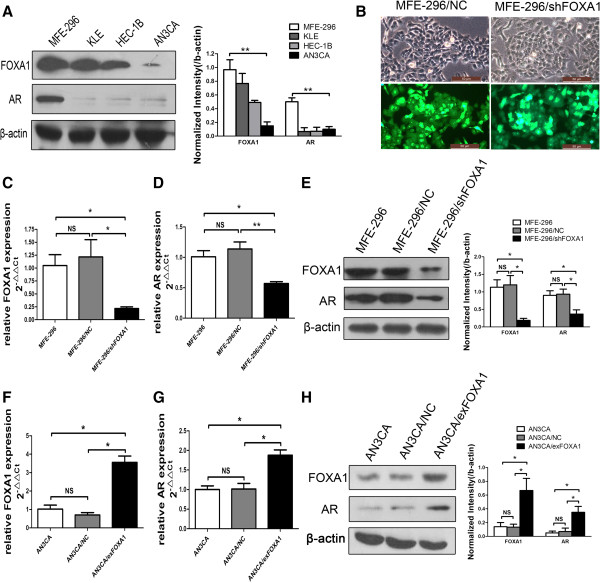
FOXA1 affects the expression of AR in human EC cells. A: FOXA1 and AR expression in the indicated EC cell lines as determined were measured by western blotting (Left), and further quantified by densitometry of triplicate experiments (Right). β-actin was used as a loading control. B: Stable transfection of MFE-296 cells with negative control vector (MFE-296-NC) or shFOXA1 (MFE-296-shFOXA1). By comparing the cells in white light (the upper panels) with the cells in green fluorescence (the lower panels), the percentage of transfected/fluorescing cells was estimated at >85%. Magnification, ×400. C: Quantification of FOXA1 mRNA by qRT-PCR in untransfected MFE-296 (MFE-296), MFE-296 transfected with shRNA control plasmid (MFE-296/NC), and MFE-296 transfected with shFOXA1 (MFE-296/shFOXA1). D: Quantification of AR mRNA by qRT-PCR in MFE-296, MFE-296/NC, and MFE-296/shFOXA1 cells. E: FOXA1 and AR expression in MFE-296, MFE-296/NC and MFE-296/shFOXA1 cells were measured by western blotting (Left), and further quantified by densitometry of triplicate experiments (Right). F: Quantification of FOXA1 mRNA by qRT-PCR in untransfected AN3CA (AN3CA), AN3CA transfected with control plasmid (AN3CA/NC), and AN3CA transfected with FOXA1 expression plasmid (AN3CA/exFOXA1). G: Quantification of AR mRNA by qRT-PCR in AN3CA, AN3CA/NC, and AN3CA/exFOXA1 cells. H: AR and FOXA1 expression in AN3CA, AN3CA/NC and AN3CA/exFOXA1 cells were measured by western blotting (Left), and further quantified by densitometry of triplicate experiments (Right). *p < 0.05, **p < 0.01, NS p > 0.05 compared with NC.